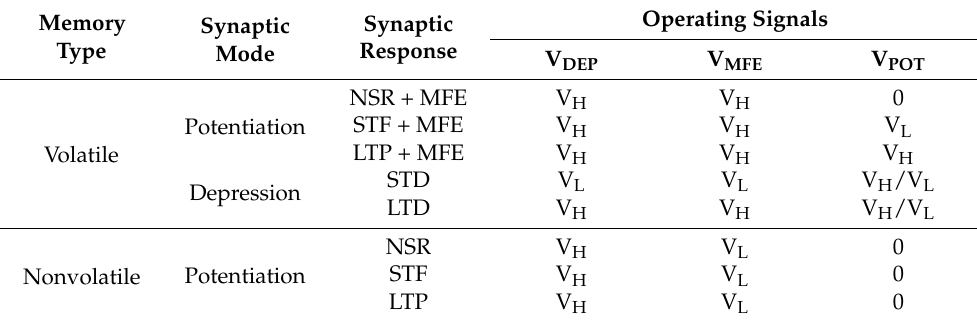
Table 1. Modes of operation of the proposed neuro-memristive